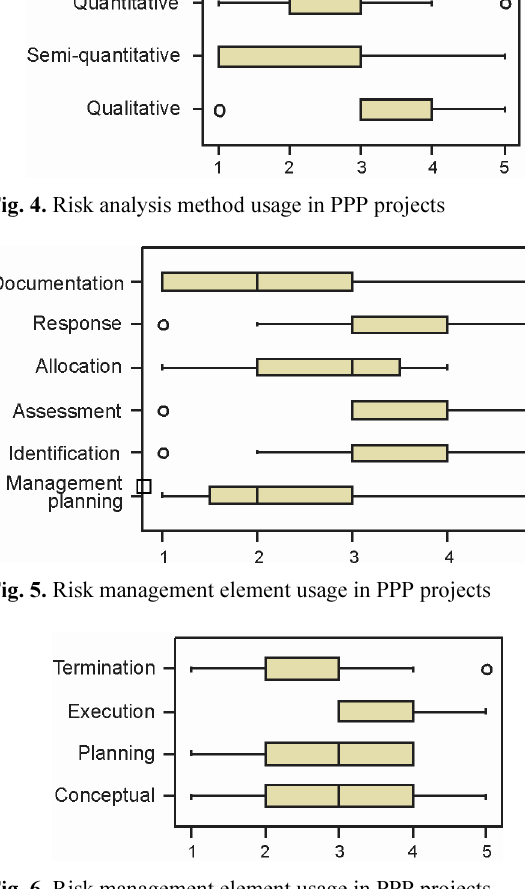
Fig. 6. Risk management element usage in PPP